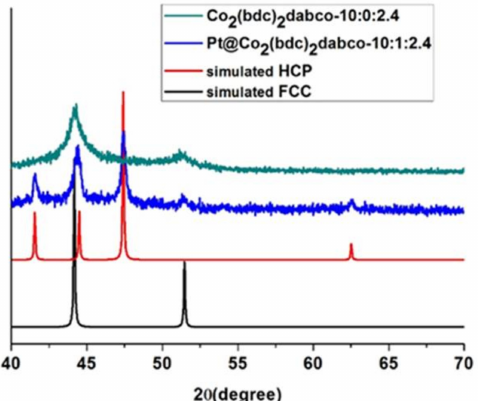
Figure 1. ( a ) Powder X-ray diffraction (PXRD) analysis and ( b ) Brunauer–Emmet–Teller (BET) analysis of M 2 (bdc) 2 (dabco) before carbonization.